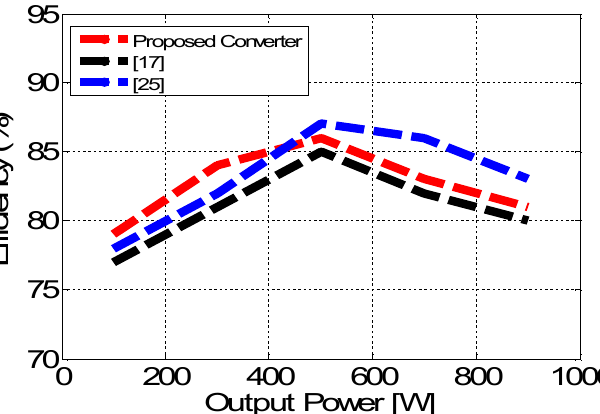
Figure 24. Measured efficiency of the proposed converter and converters in [17,25] with D = 0.1.